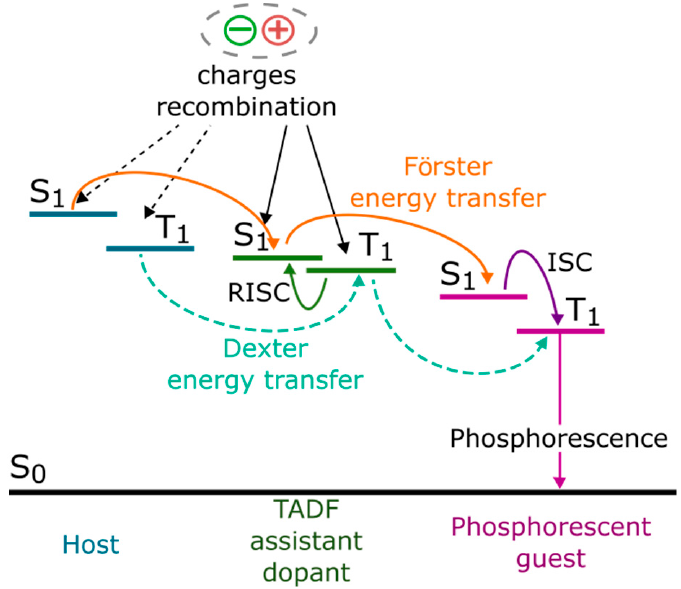
Figure 1. The energy transfer diagram of light emitting system with thermally activated delayed fluorescence (TADF) assistant dopant and phosphorescent emitter.